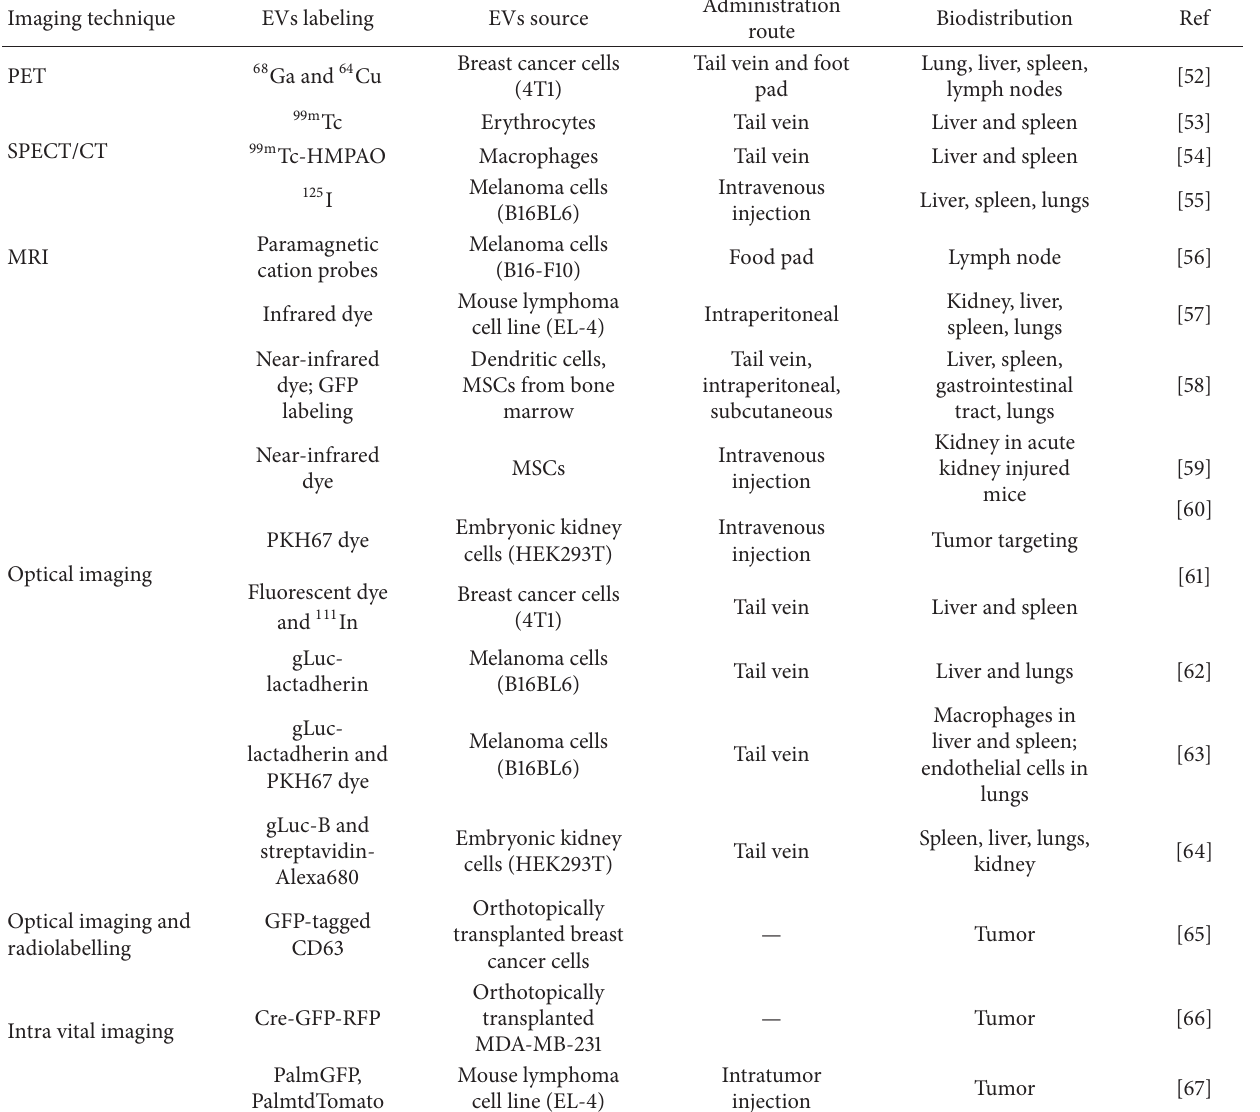
Table 1: Imaging studies investigating extracellular vesicles (EVs) biodistribution in vivo